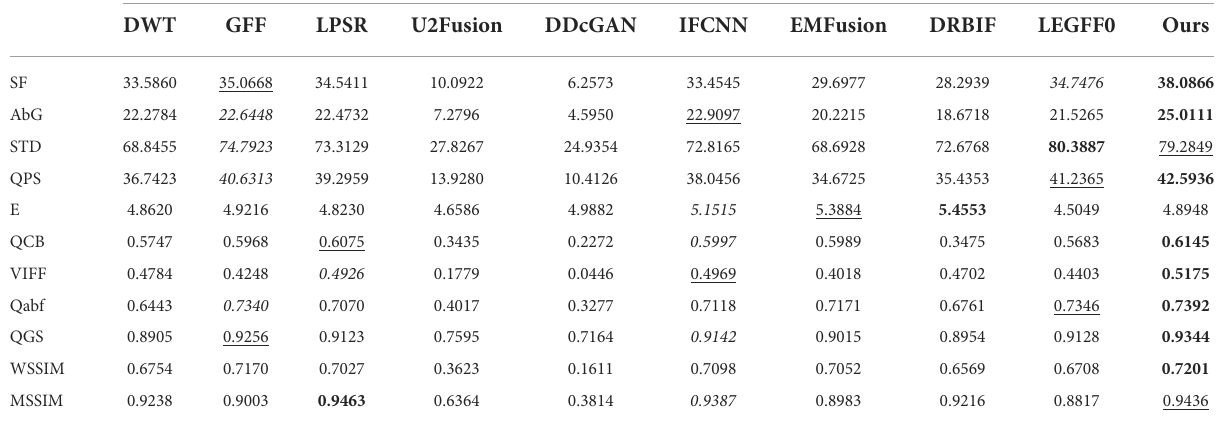
TABLE 2 Quantitative evaluation results on the PET-MRI